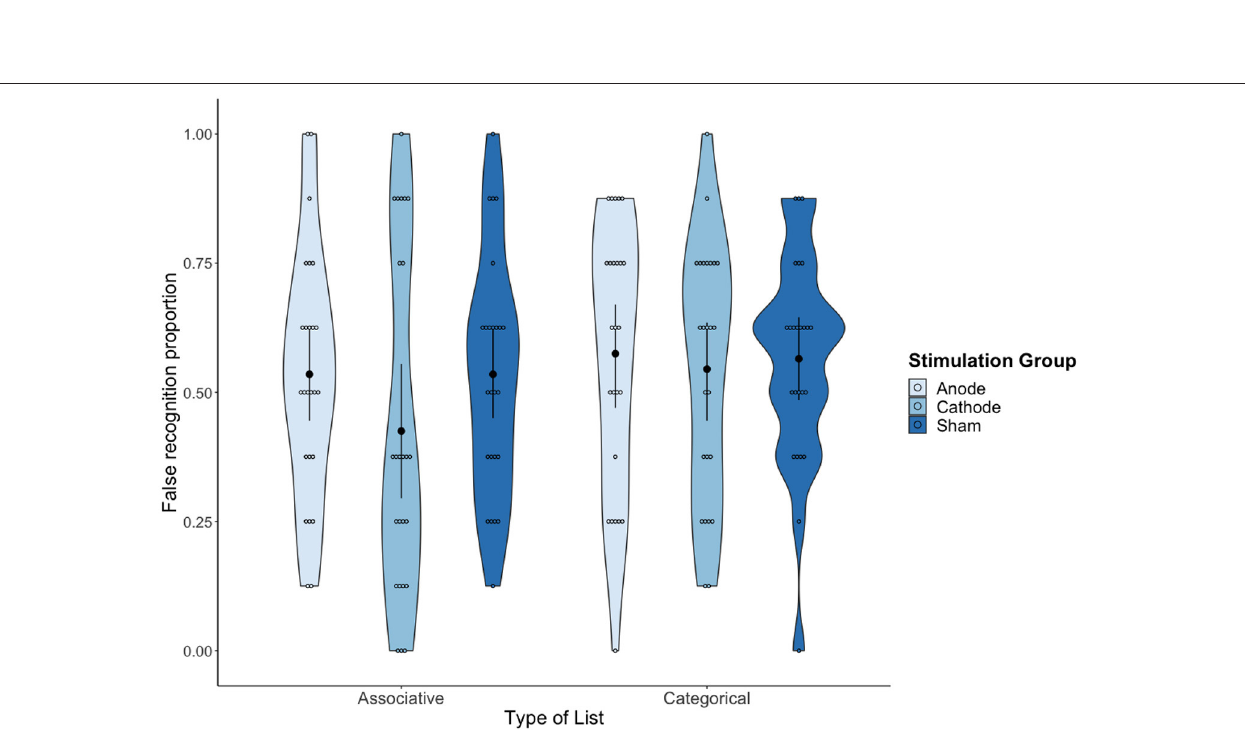
FIGURE 3 | Mean proportion of false recognition as a function of tDCS condition and Type of list. Error bars represent 95% confidence intervals (CIs).